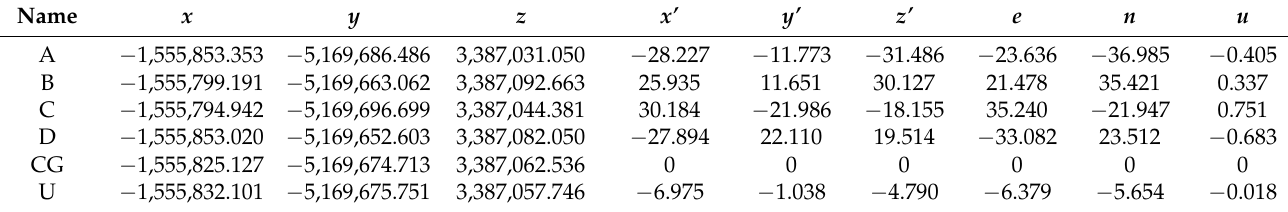
Table 5. Station coordinates in ITRF 2014 in XYZ , local XYZ , and ENU coordinate